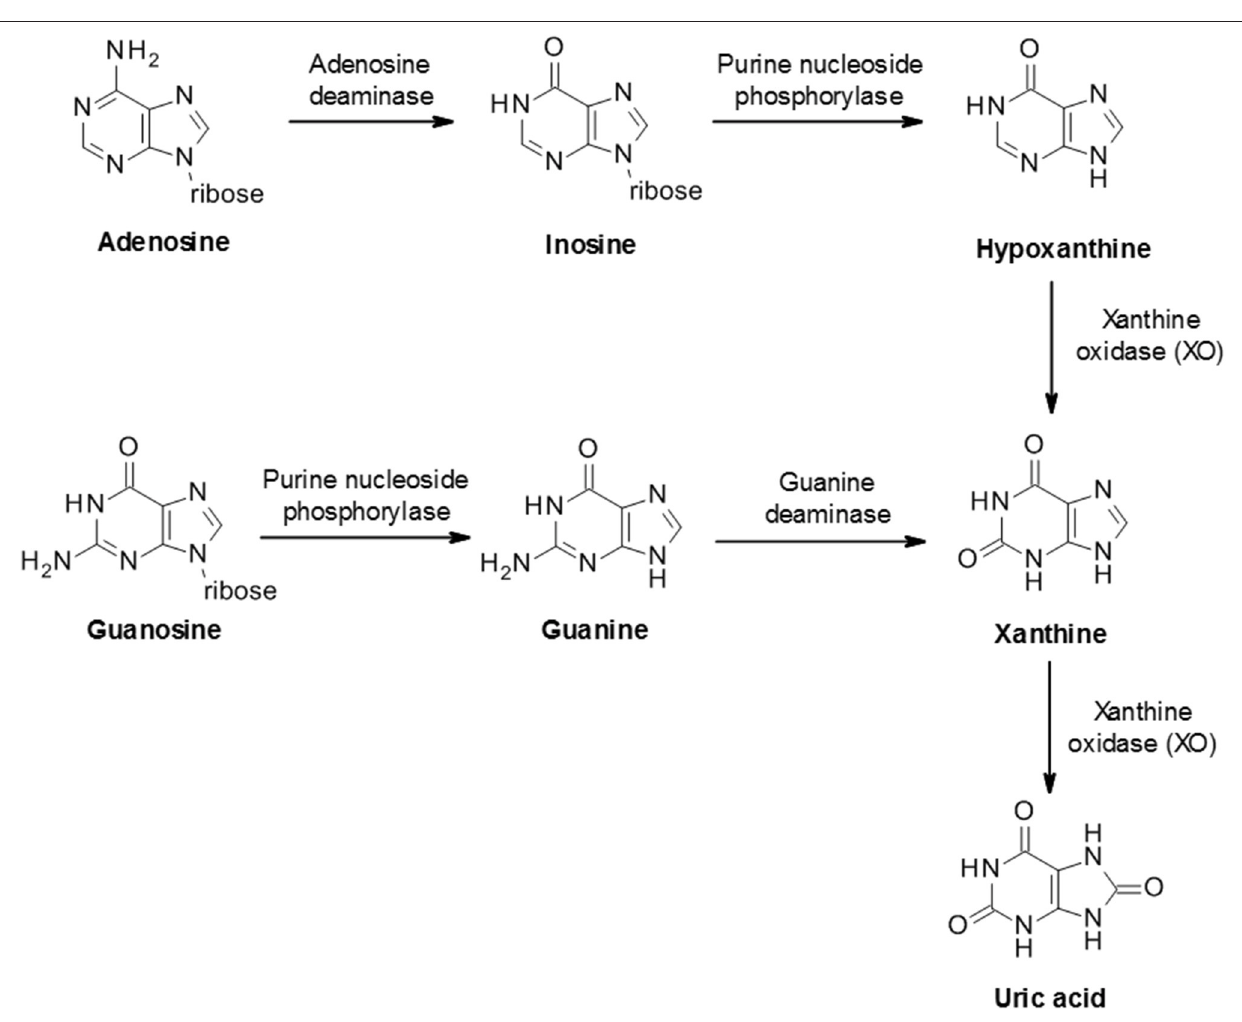
have an average FEUA in the range of 6–8%, whereas gout patients generally have average FEUA of 3–5% (34–36). These observations are consistent with the notion that decreased